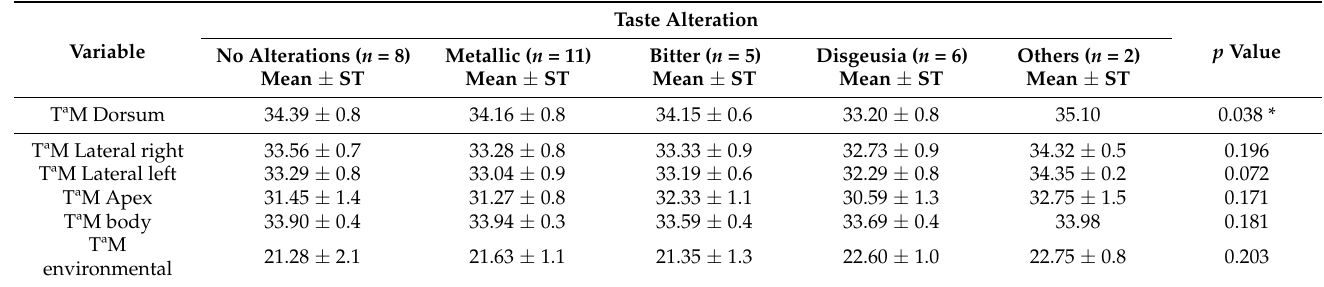
Table 2. Taste alteration distribution in burning mouth syndrome patients.